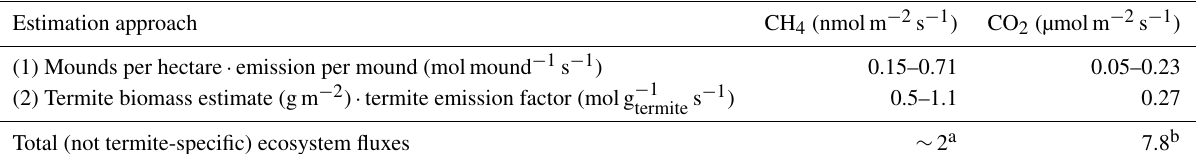
Table 4. Overview of termite-induced CH 4 and CO 2 emissions based on two different approaches. For comparison, the lowest row shows the total (not termite-specific) ecosystem CH 4 and CO 2 flux values, measured at the same field site by previous studies. Estimation